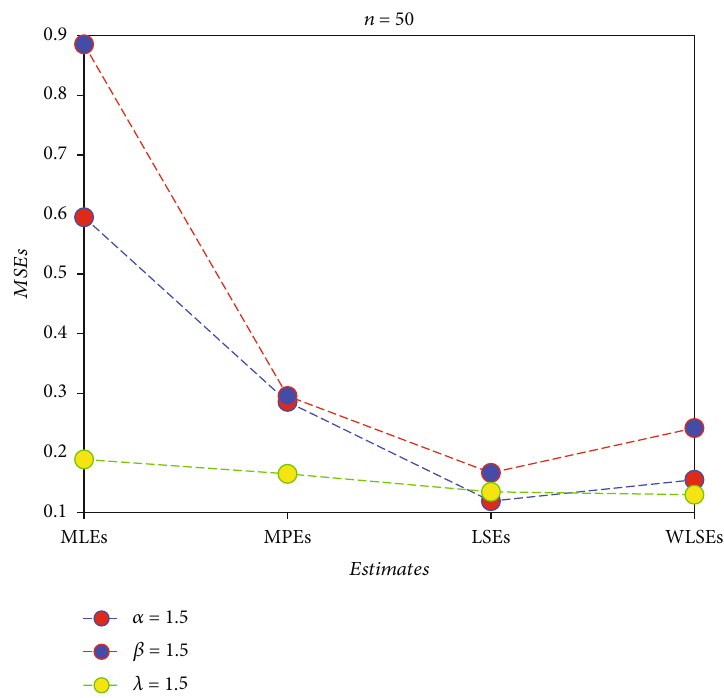
Figure 11: MSEs using n = 50 : α = 1 : 5 , β = 1 : 5 , and λ = 1 : 5